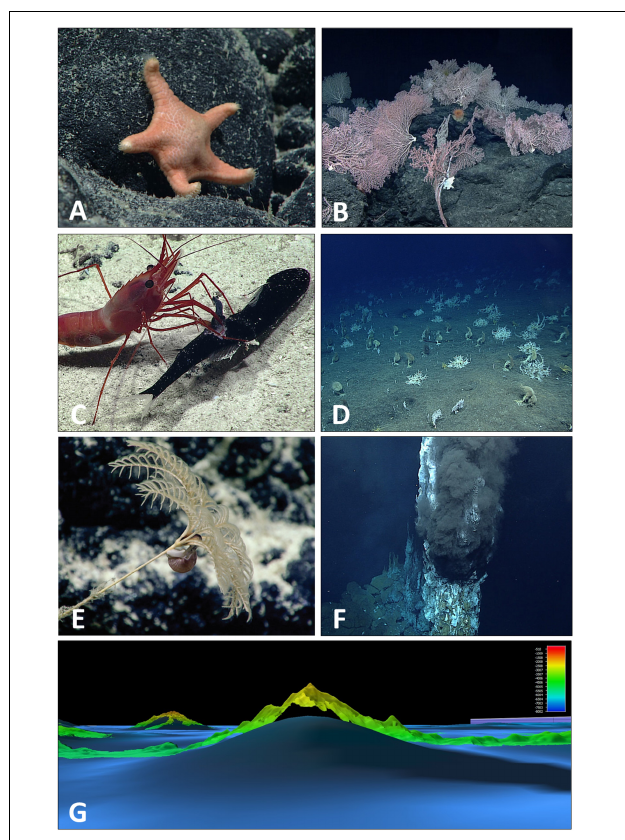
FIGURE 7 | Plate of CAPSTONE curiosities: novel taxa, features, and interactions. Several new genera and new species were observed and collected during CAPSTONE, including (A) a previously undescribed genus and species of sea star (family Goniasteridae, class Asteroidea) (C. Mah, personal communication, description in preparation) discovered in the Musicians Seamounts in 2017 (EX1708). In several areas, CAPSTONE expeditions documented deep-sea corals for the first time, including (B) in the Musicians Seamounts (EX1708) where coral communities were observed on every dive not focused on water column exploration or archeology characterization. As the number of observations in the deep sea are limited when compared to the size of the biome, every predator–prey interaction observed contributes to our understanding of deep-sea life history. (C) A caridean shrimp, Heterocarpus sp., was observed capturing and feeding on a mid-water dragonfish, potentially Astronesthes sp., at Ufiata Seamount in Tokelau (EX1703), an unusual observation as Heterocarpus sp. are typically thought to be scavengers. Of particular interest to CAPSTONE were high density communities. Although most observed during CAPSTONE were composed of corals and sponges (Demopoulos et al., 2018; Smith et al., 2018) (D) at Zealandia Bank in the Marianas (EX1603L1) we documented a rarely observed large aggregation of gorgonocephalid basket stars. (E) In the deepwater areas around Kingman Reef (EX1705) several gastropods were observed with mouth apparently placed on the anal vent of multiple bathycrinid stalked crinoids, reminiscent of coprophagus snails (Platyceratidae) known from Paleozoic fossils but thought to be extinct. CAPSTONE also included exploration of hydrothermal vents in the Marianas (EX1605L1 and L3) revealing three new site of hydrothermal activity, including (F) the first survey of a new black smoker vent field composed of multiple chimneys in the Mariana Back Arc. Multibeam data collected over areas that had previously only been mapped using satellite altimetry, often showed significant differences in depth or form of features. (G) In the Jarvis Unit of PRIMNM, multibeam data (EX1701) revealed an approximate 1,700 m height difference when compared to previous satellite